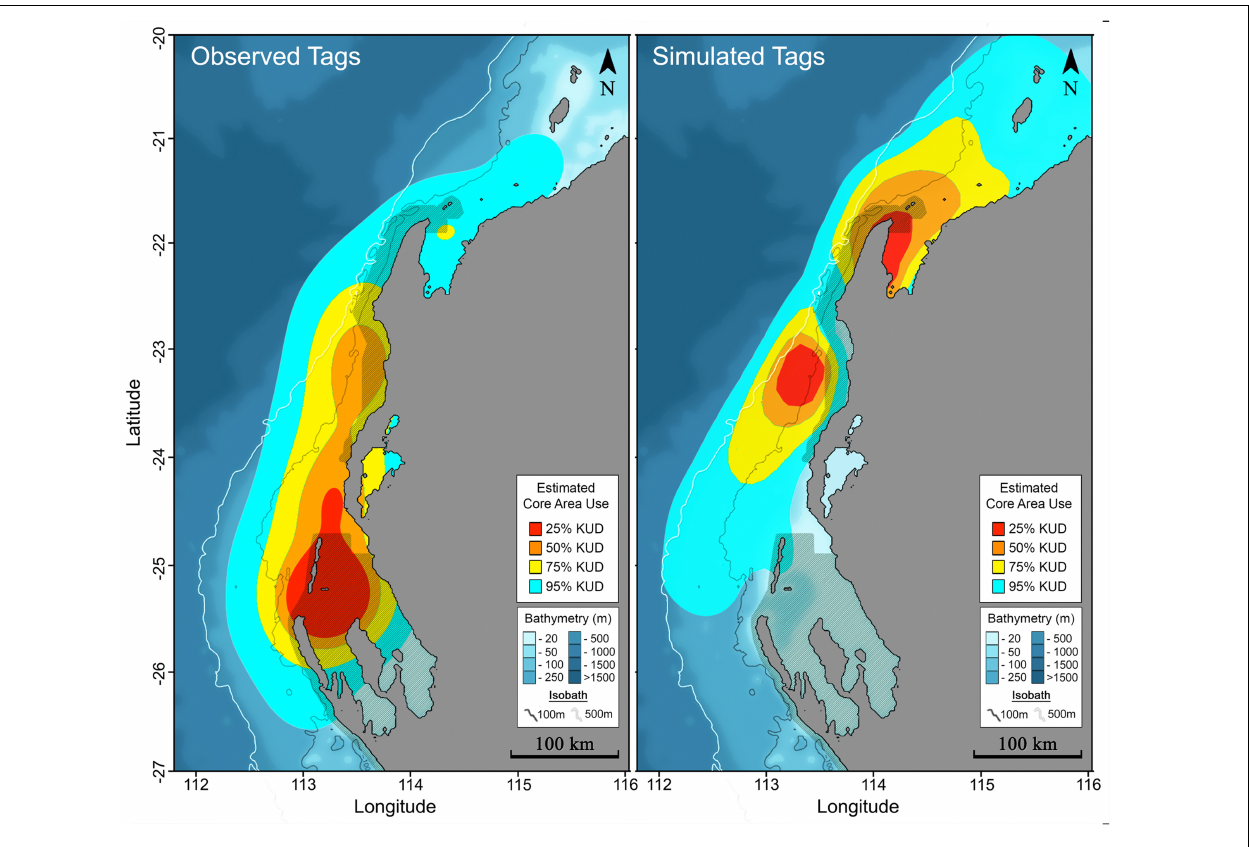
25%, 50%, 75% and 95% kernel utilisation density (cid:32) (cid:32) (cid:32) (cid:32)